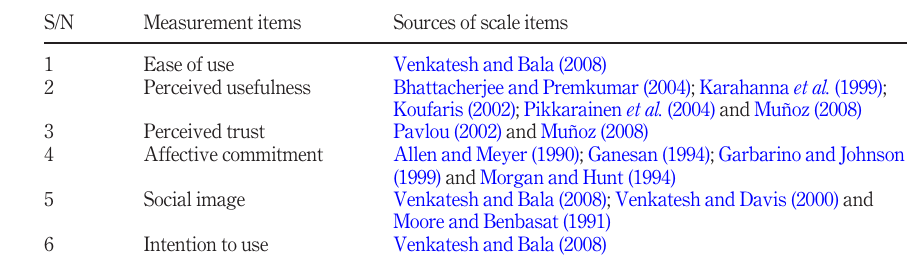
S/N Measurement